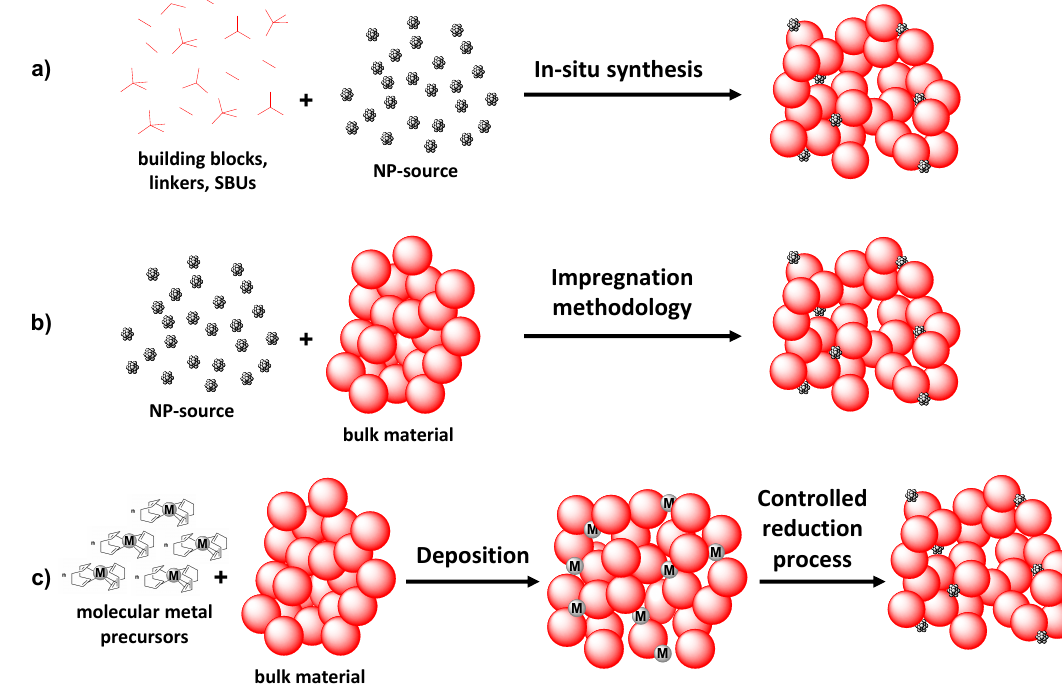
Figure 10. Synthetic strategies of hybrid materials with metal NPs: a ) In ‐ situ synthesis. b ) Impregnation methodology. c ) Controlled ‐ reduction process .